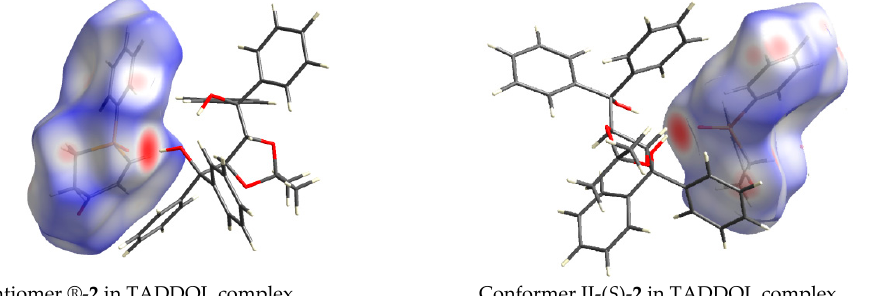
Figure 8. The Hirshfeld surfaces (d norm ) for molecules ( R )- 2 and II-( S )- 2. The atoms with contacts shorter than the van der Waals radii are marked in red.